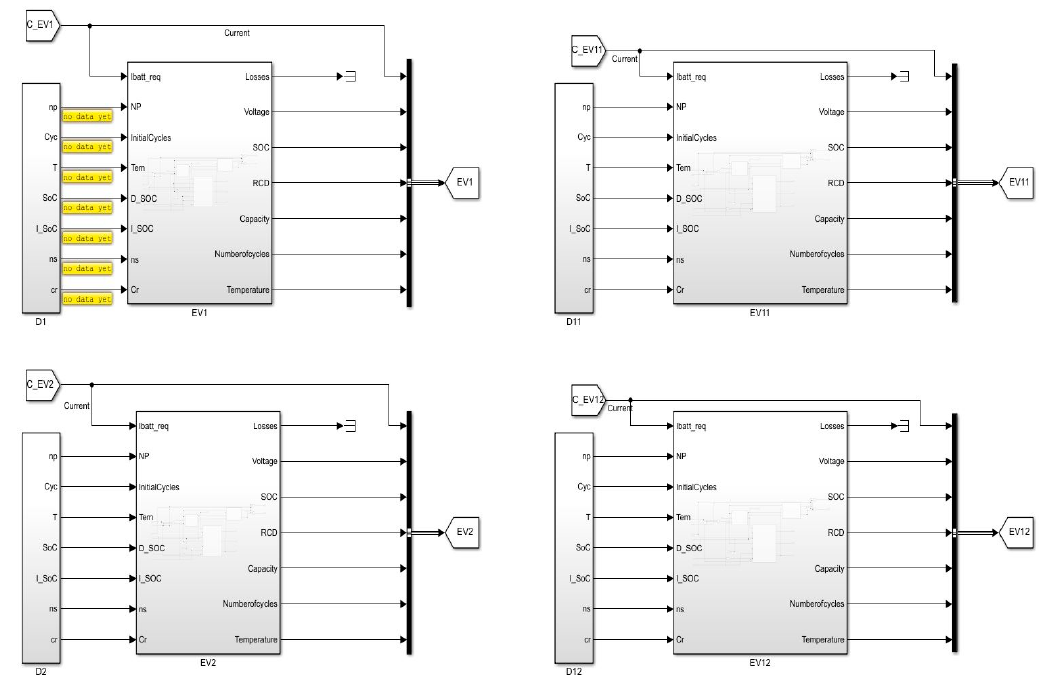
Figure 8. Individual EV model in the framework of an aggregator.